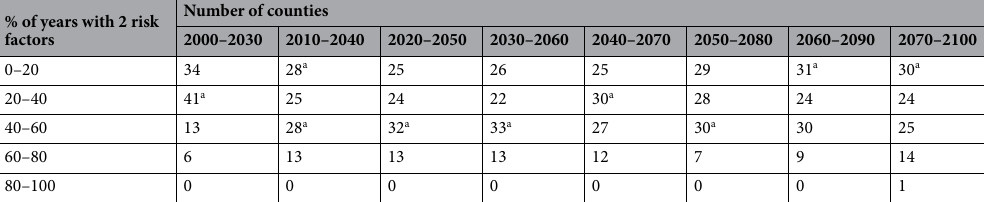
Table 1. Number of counties (n = 94) with different percentages of years with 2 weather risk factor thresholds exceeded under the RCP 4.5 scenario. a Dominant proportion of years with 2 risk factors for 30-year period.